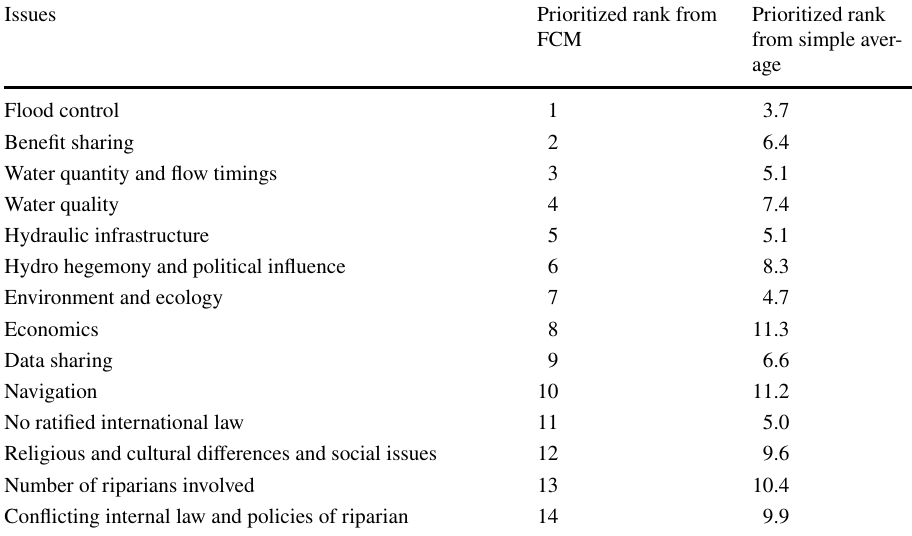
Table 4 Prioritized rank of transboundary issues